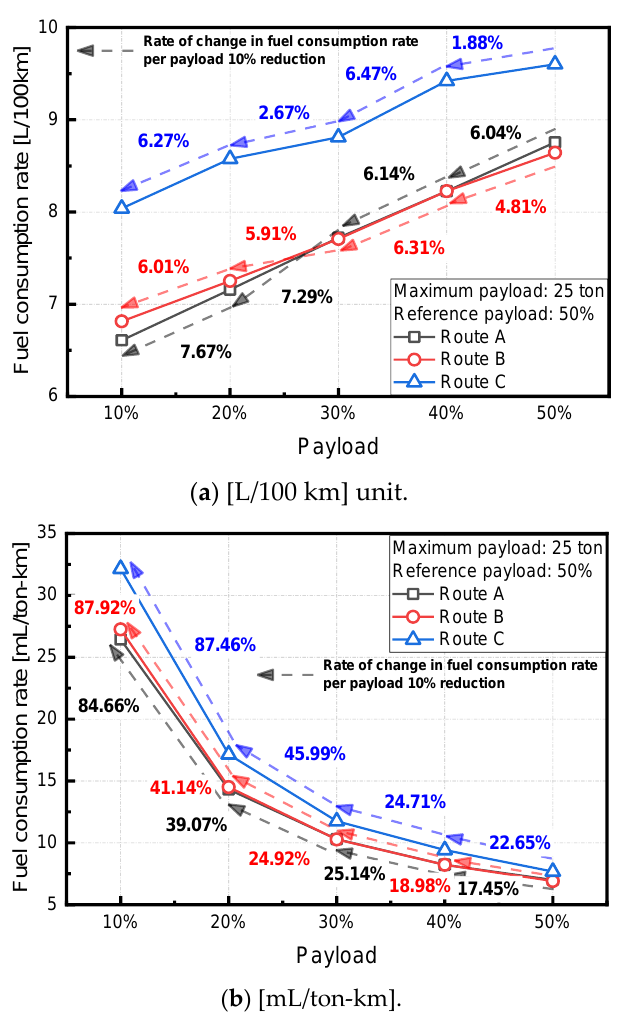
Figure 6. Fuel consumption rate with respect to payload for each route.